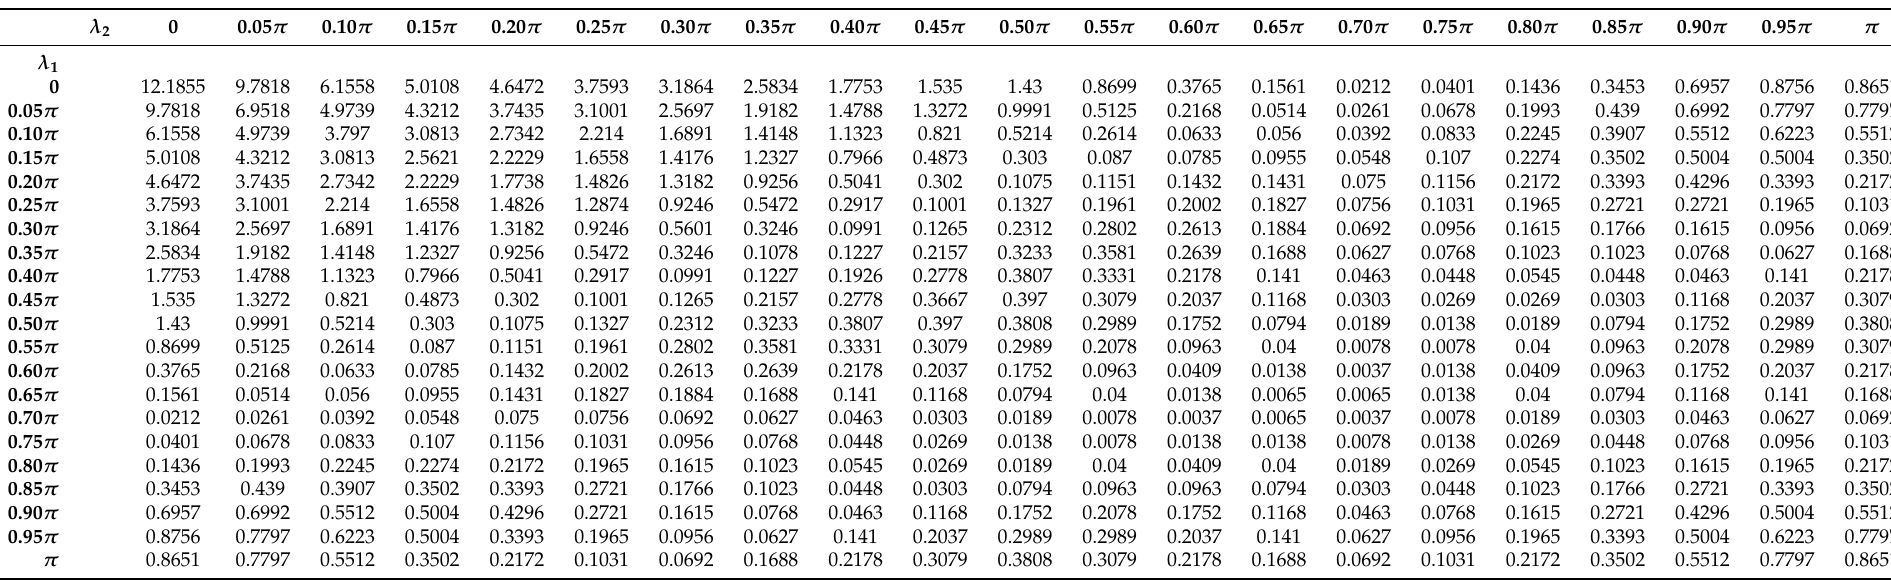
Table 4. Numerical values of smoothed multitapered biperiodogram of DCGINAR(1) model with M = 14 and β =